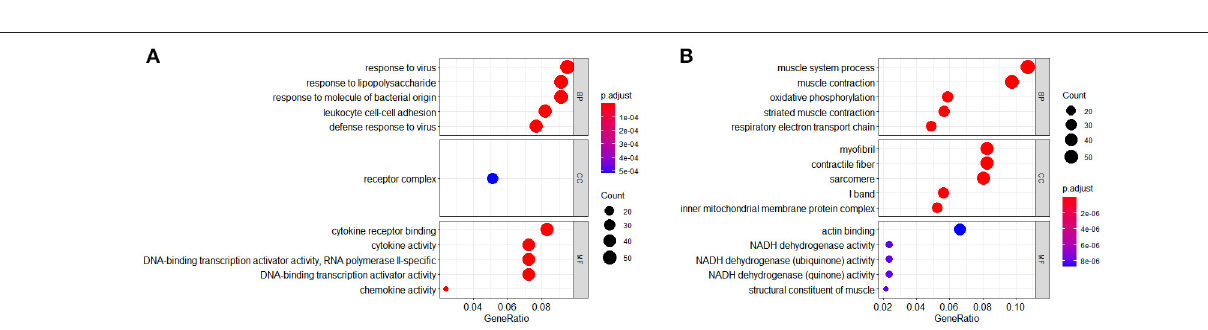
FIGURE 3 | Gene ontology (GO) analysis (BP, CC, and MF) of differentially expressed genes (DEGs). (A) GO terms of upregulated DEGs. (B) GO terms of downregulated